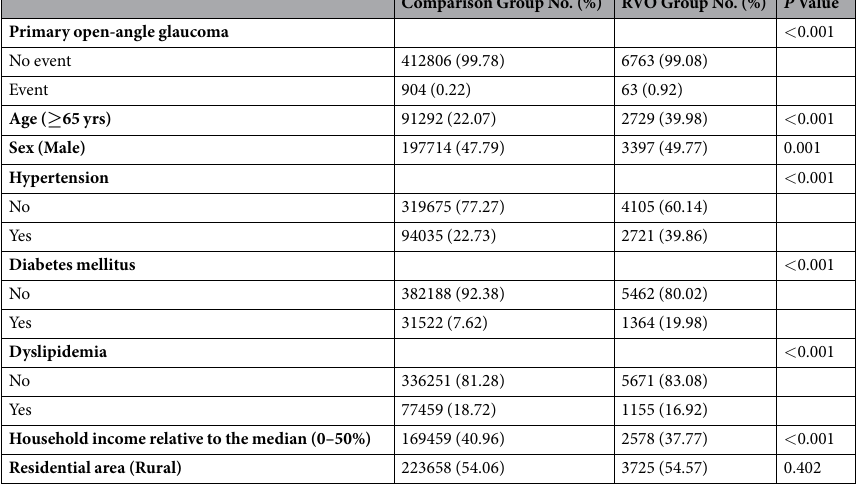
of hypertension increased the frequency of POAG development in patients with RVO compared to patients with RVO but without hypertension ( P < 0.001; Fig. 1A). The log rank tests indicated that the patients with POAG developed RVO significantly more frequently than the comparison group ( P < 0.001). However, comorbidity of hypertension did not increase the frequency of RVO development in patients with POAG compared to patients with POAG but without hypertension ( P = 0.786; Fig. 1B). When considering the effect of comorbidities to the development of RVO or POAG, we found different effects according to the baseline disease (Table 5). In patients with RVO who developed POAG, combined comorbidities including hypertension, diabetes mellitus, and dyslipidemia increased the risk of developing POAG. However, in patients with POAG who developed RVO, systemic comorbidities did not increase the risk of developing RVO.